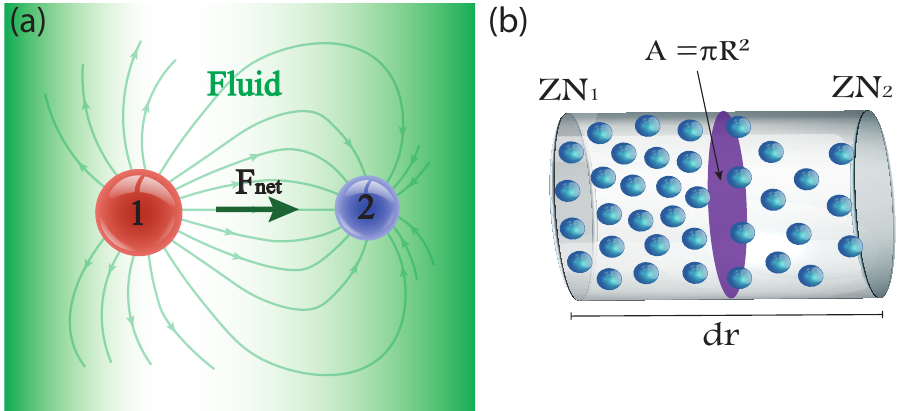
Figure 2. ( a ) Pairwise interaction of 2 clusters via the radial force field in Equation (13). ( b ) Volume element that shows the gradient in the number of fluid particles (fluid particles in blue and cross- section of cluster 1 in purple) that generates a force acting on cluster